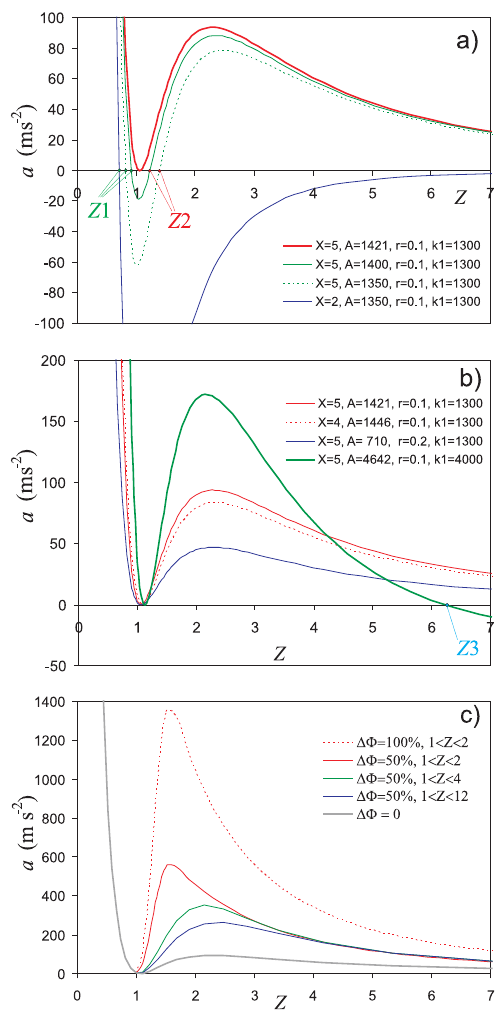
Fig. 5. Characteristics of the function a(Z) : (a) increasing value of A leads to loss of equilibrium (blue – stable flux-rope, green – metastable flux-ropes; red – unstable flux-rope); (b) unstable flux- rope for various input parameters (gravity is included only in the case shown by green bold line) (c) the effect of reconnection which supplies the magnetic flux 18 e ; gray line represents the case with- out reconnection shown in (a) and (b) by the red line ( 18 e = 0). Parameter values are written in the legend. Z is the height of the flux-rope axis expressed in units of the footpoint half-separation d . Stable and metastable equilibria are indicated by green dots (de- noted as Z 1), the unstable equilibria are drawn by red dots ( Z 2), and the upper (stable) equilibrium is marked by blue dot ( Z